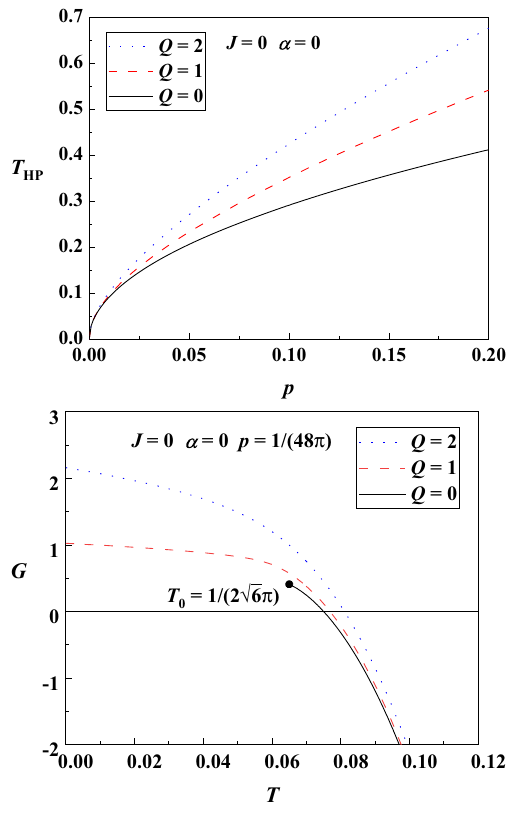
Fig. 13 The T HP – p and G – T curves of the RN–AdS black holes with- out the GB term in the canonical ensemble with fixed